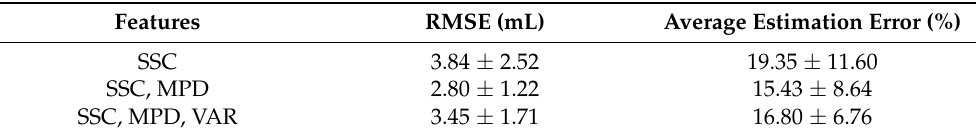
Table 5. The table shows how the RMSE and the average estimation error change for the ANN as features are added. Performance deteriorated with the addition of a third feature; thus, it was not deemed necessary to proceed with further feature